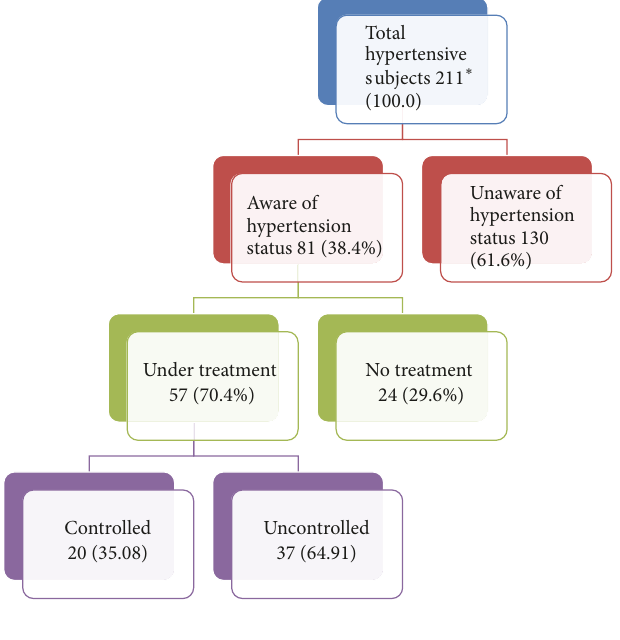
Figure 1: Flow diagram showing awareness, treatment, and adequacy of control of hypertension among study